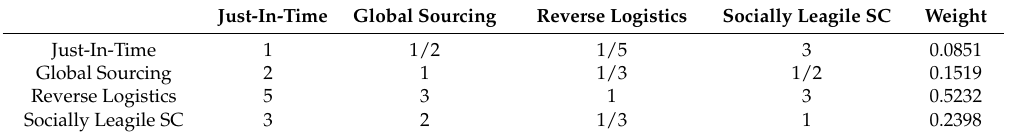
Table A6. Pairwise Comparison of Alternatives w.r.t. sub-criterion Green Packaging.